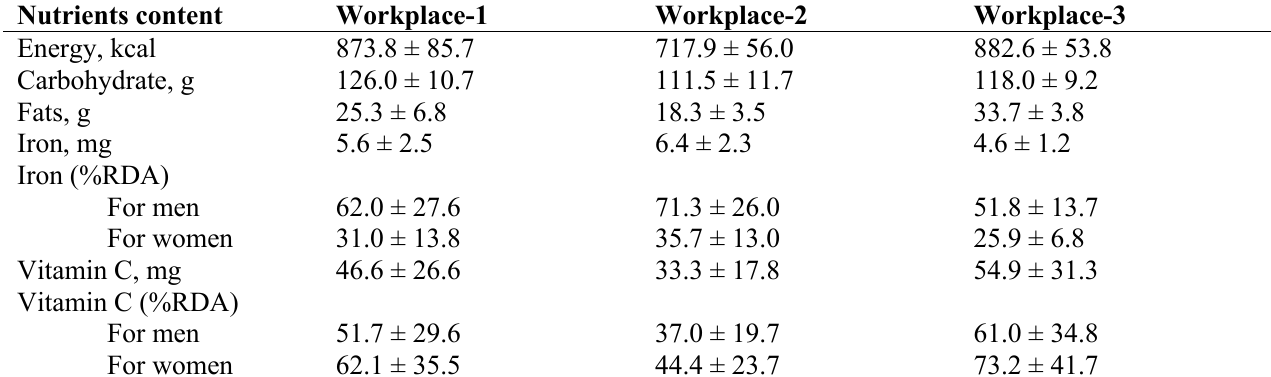
Table 4. Nutritional facts and its adequacy from meals provided at the three different workplaces Nutrients